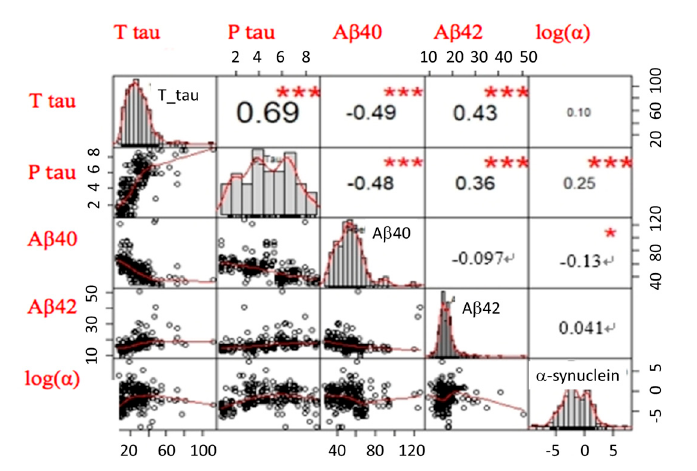
Figure 2. The correlation matrix between each biomarker from four groups, including healthy controls, as well as patients with Alzheimer’s disease (AD) spectrum, Parkinson’s Disease (PD) spectrum, and Frontotemporal Dementia (FTD). The upper triangular part of the matrix is the correlation coefficients between any two biomarkers. The lower triangular part of the matrix is the scattered-plot graphs of any two biomarkers. The main diagonal part of the matrix is the distribution graphs of each biomarker. log( α ) is the log of α -synuclein. * p < 0.05; *** p < 0.001.